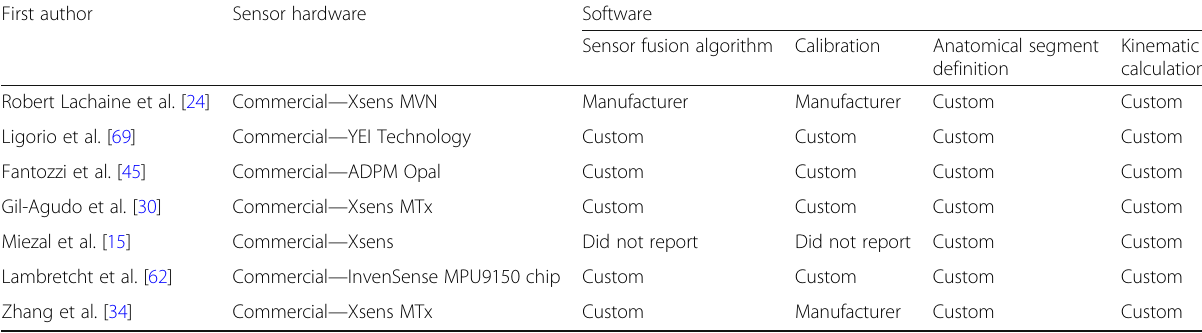
Table 4 Summary of the software customisation reported by the authors for validation studies that used the same